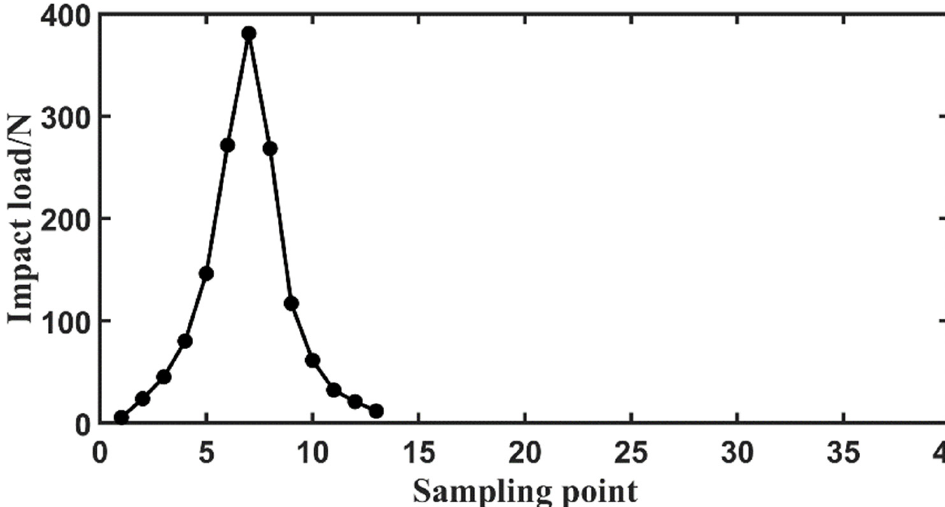
Figure 14. A certain impact load in the test.